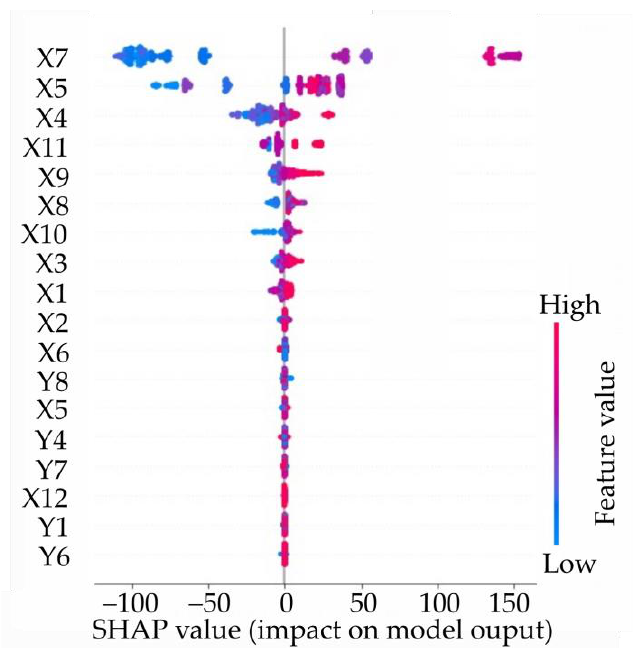
Figure 5. Evaluation results of factor values based on SHAP. A redder color represents a larger impact factor, and a bluer color is a smaller impact factor.